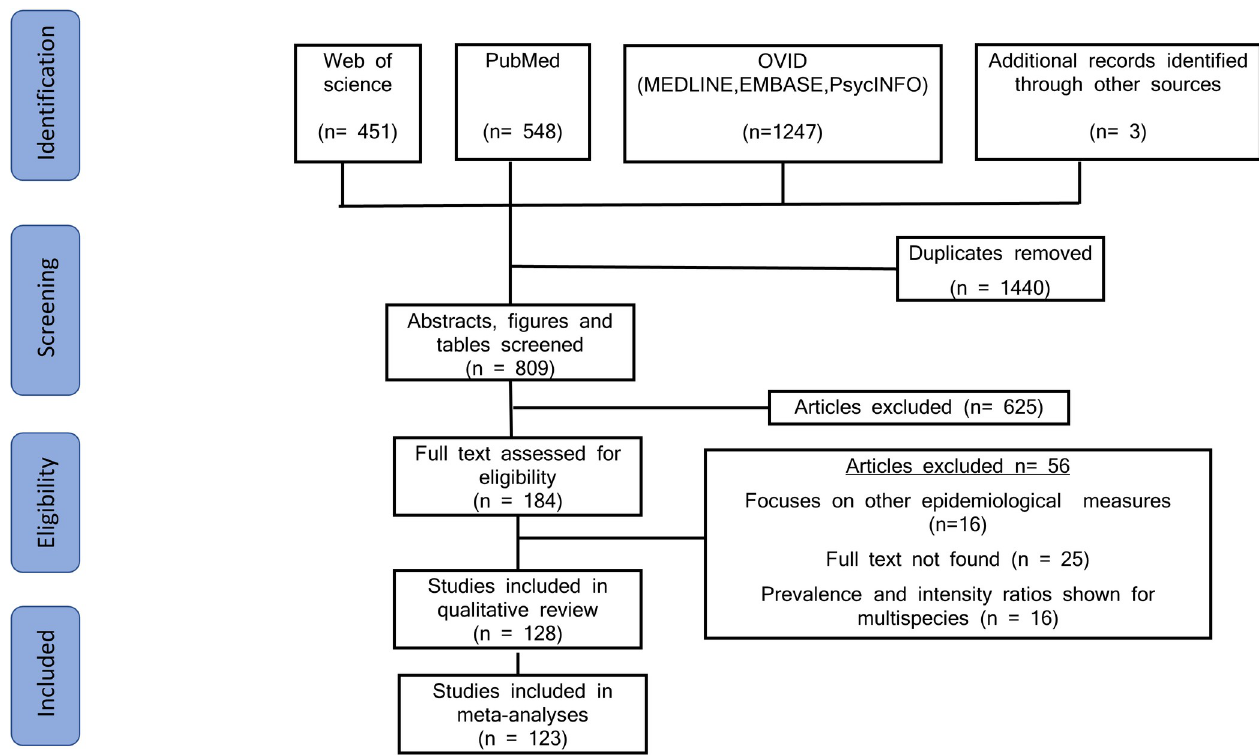
Fig 1. PRISMA diagram summarising inclusion and exclusion of all identified papers.